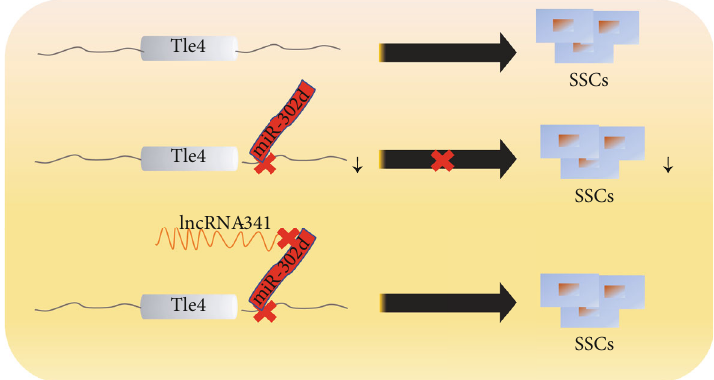
Figure 10: Interactive pattern of miR-302d and lncRNA-341 and